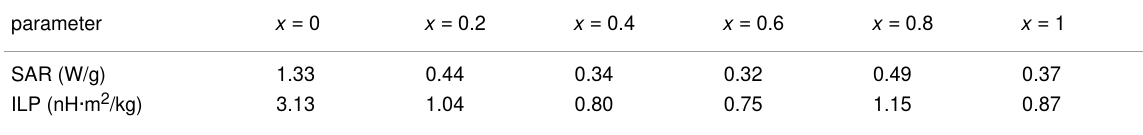
Table 4: The values of SAR and ILP of the samples important for the hyperthermia therapy. parameter